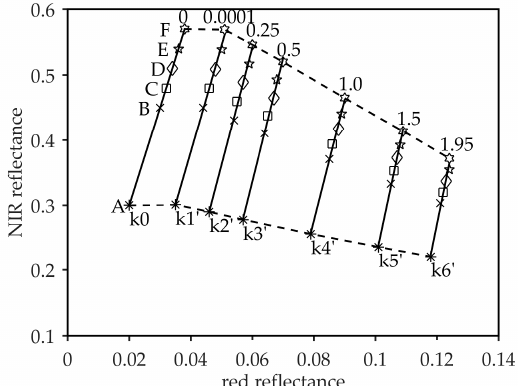
Figure 2. Fitted lines through six points (A–F) representing six partial canopy pixels with the same aerosol free NDVI in different AOD conditions (each symbol represents one canopy, k0 is the slope of the aerosol free NDVI isoline and transition from k1 ′ to k6 ′ represents the variation of AOD from 0.0001, 0.25, 0.5, 1.0, 1.5 to 1.95).